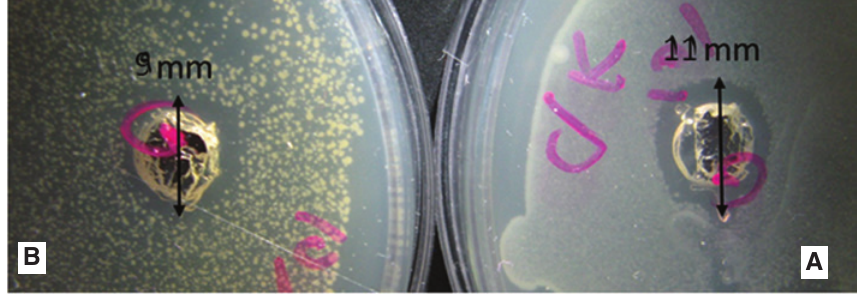
Figure 8: Created zones of inhibition with (A) S. aureus and (B) E. coli incubated at 37 ° C for 24